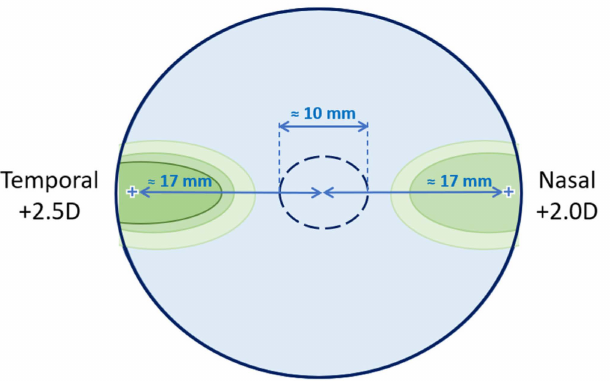
Figure 1. Schematic figure of the lens design according to the manufacturer. This represents the lens for the right eye, at 38 mm in diameter. The central monofocal correction circle is 10 mm in